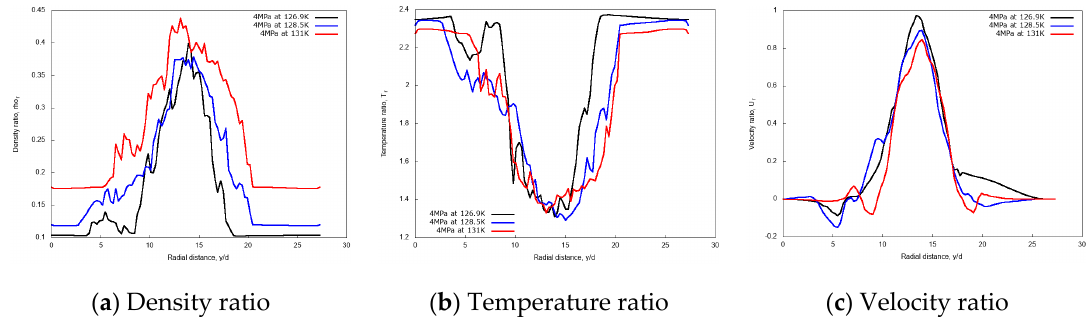
Figure 7. Radial profiles of non-dimensional density, temperature, and velocity ratios at fixed axial distance x / d = 20, for different injection temperatures: 126.9 K, 128.5 K, and 131 K. Simulations of cryogenic L-N 2 injected at 4.9 m/s into G-N 2 at 4 MPa and 298 K.